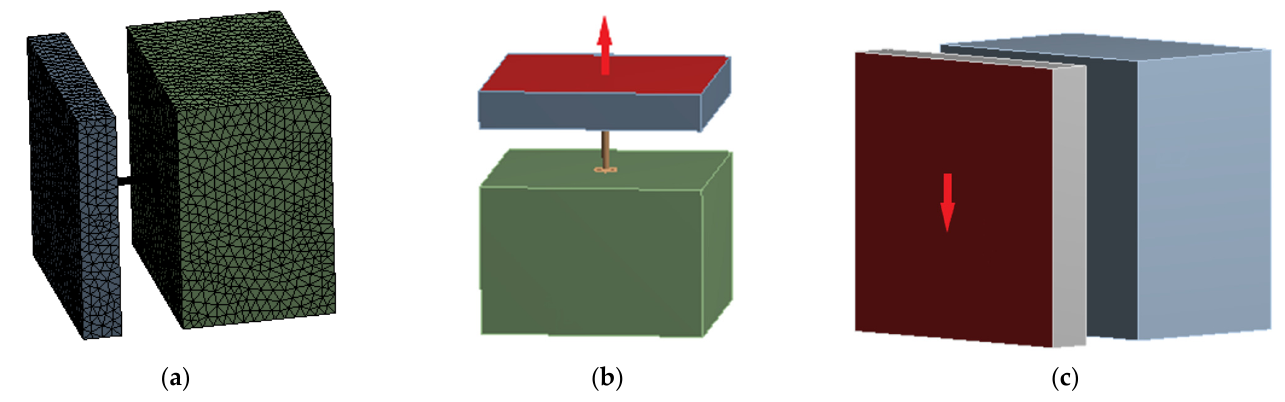
Figure 12. Precast, insulated, concrete sandwich-wall-panel unit-force model: ( a ) Grid division; ( b ) Pull-out-force loading direction; ( c ) Shear-force loading direction.